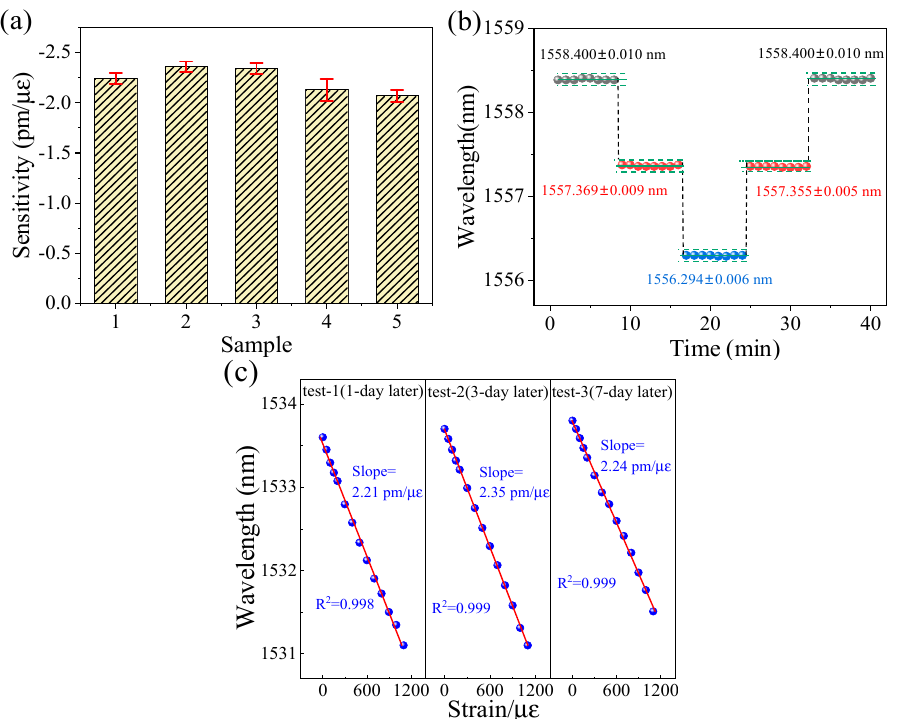
Figure 11. ( a ) Repeatability, ( b ) the short-term and ( c ) long-term stabilities of axial-strain response.